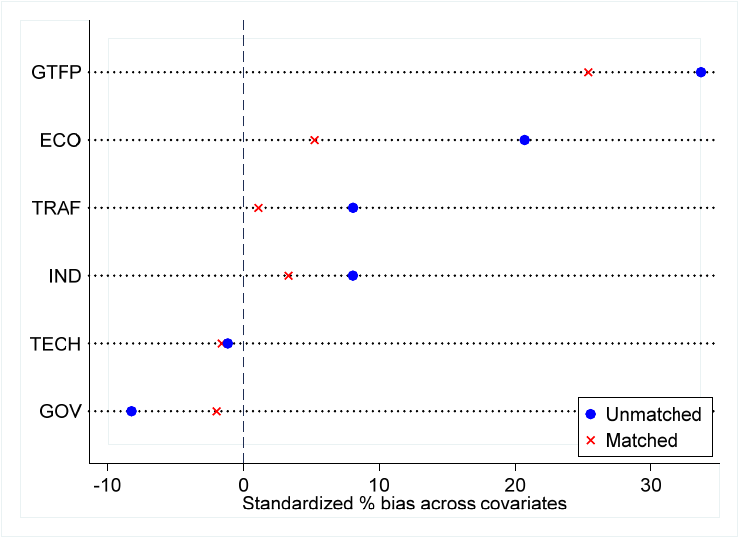
Figure 1. The standard deviation before and after matching the dependent and control variables.